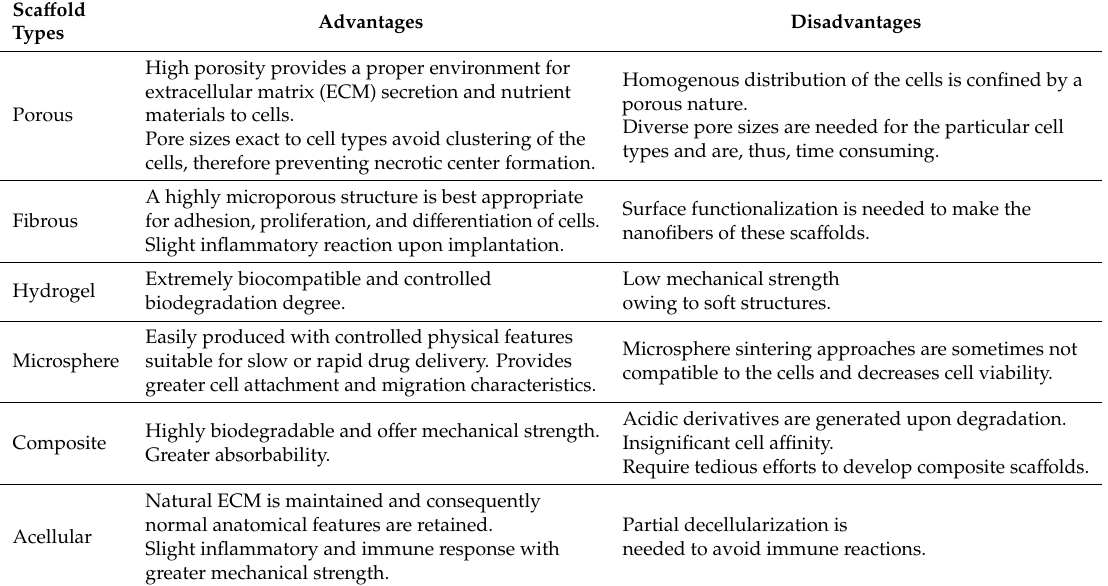
Figure 3. Different forms and morphological structures of scaffolds for biomedical applications. Figure 3. Di ff erent forms and morphological structures of sca ff olds for biomedical applications. Table 2. Advantages and disadvantages of di ff erent sca ff olds used in tissue engineering. Adapted from Table 2. Advantages and disadvantages of different scaffolds used in tissue engineering. Adapted Reference from Reference [38].